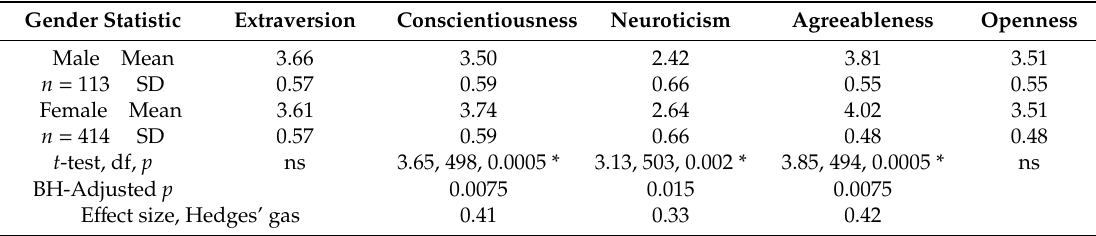
Table 5. Means and standard deviations for each of the academic confidence subscales by sex of the student.